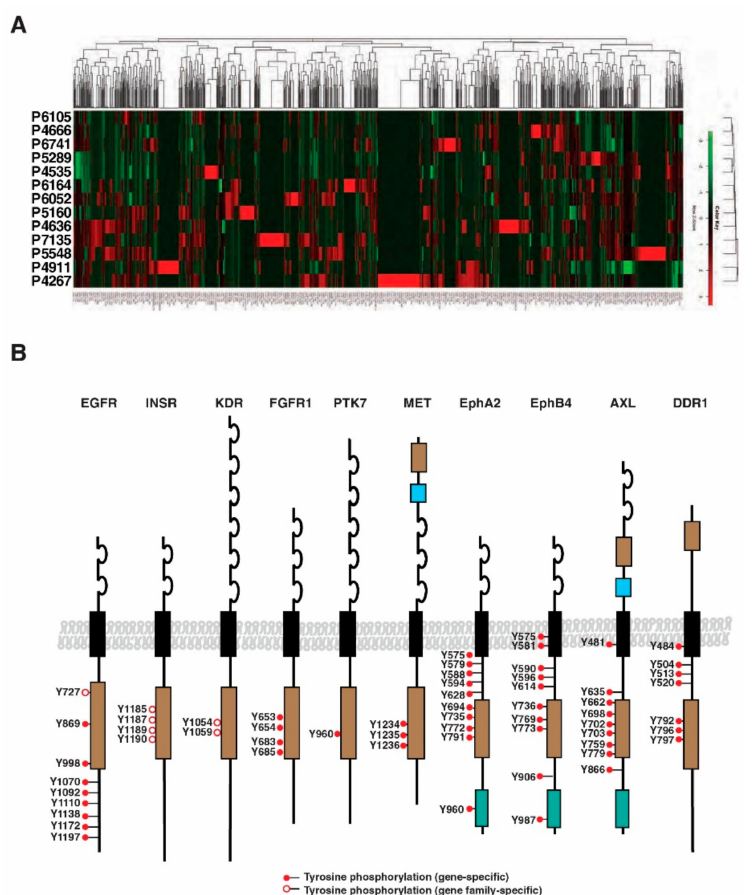
Figure 3. Widespread tyrosine activation in PDAC PDXs: ( A ) Unsupervised hierarchical clustering shows the distinct pattern of tyrosine phosphorylation in PDXs used in this study from humans. PDX sample numbers are indicated on the left margin. The color key shows peptide intensities from low (green) to high (red); ( B ) Several receptor tyrosine kinase families were found to be hyperphosphorylated, including EGFR and Ephrin receptors. All the tyrosine kinase domains were found to be tyrosine-phosphorylated, while juxta-membrane domains were phosphorylated only in some families, such as the Ephrin receptor and